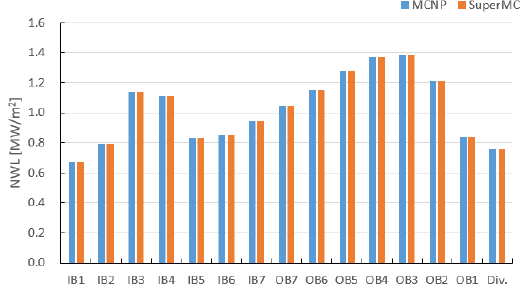
Figure 5. Profile of NWL on first